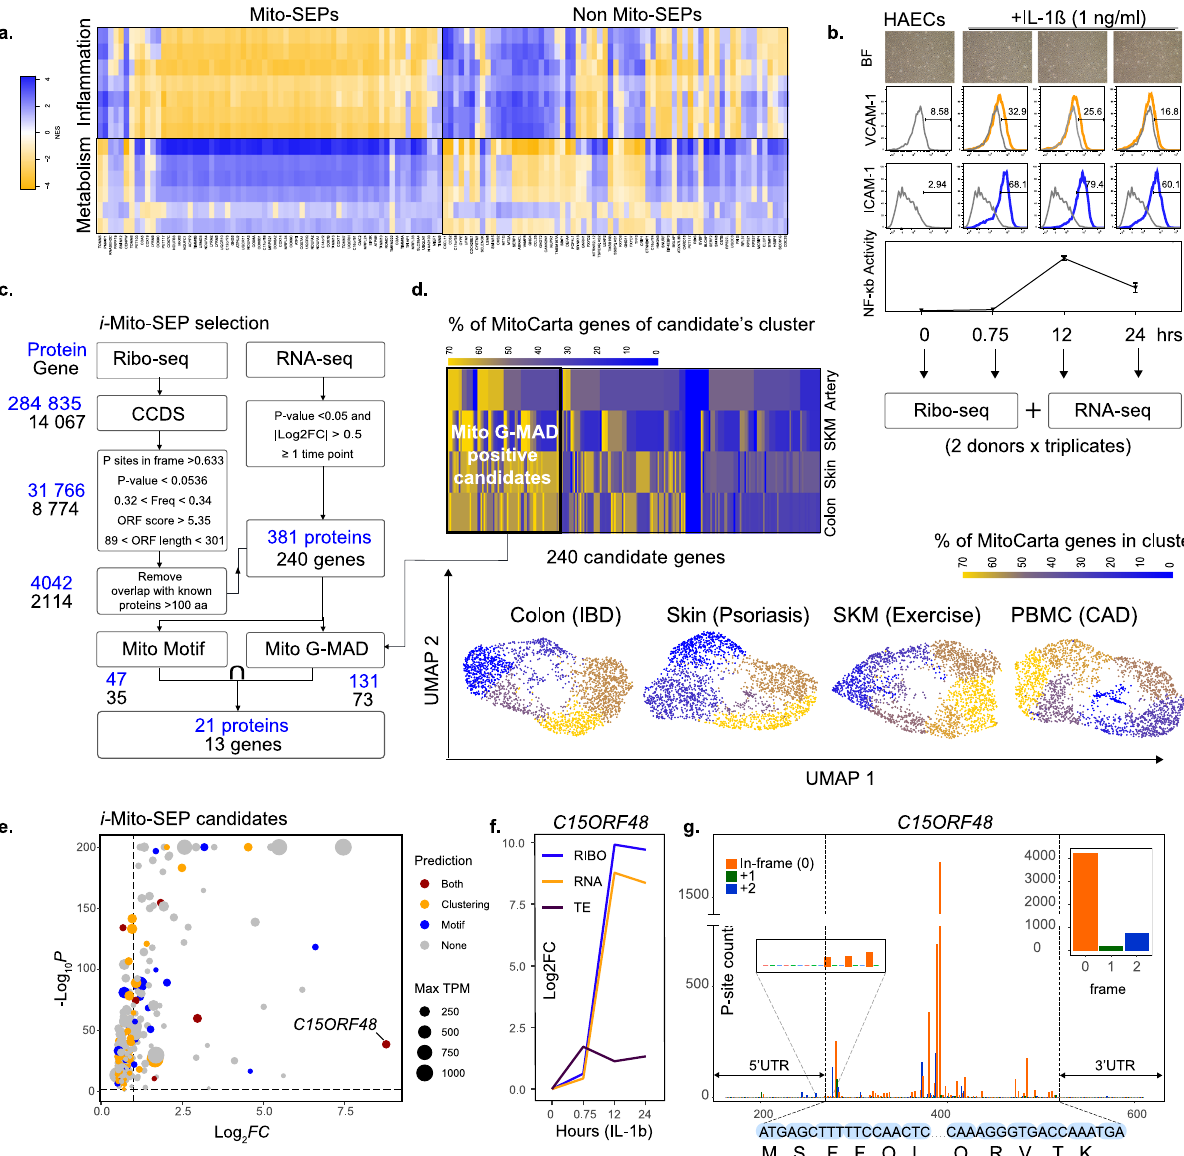
Fig. 1 Proteogenomic screen in human endothelial cells (HAECs) identi fi es MOCCI as an in fl ammatory Mito-SEP (i-Mito-SEP). a WGCNA-GSEA analysis of mito versus non-mito-SEPs in human failing heart reveals strong anti-correlation of mito-SEPs with in fl ammation. Each row represents one pathway and the pathways are separated into those that are involved in metabolism and those that are involved in in fl ammation. Color scale = NES score. Dataset used: European Genome-Phenome Archive EGAS00001002454 12 . b HAECs from two healthy male donors were treated with 1 ng/mL IL-1 β for 45 min, 12 and 24 h. All timepoints including untreated controls were analyzed by RNA-seq and Ribo-seq in triplicate. NF-kb reporter activity, ICAM-1, and VCAM-1 expression illustrate the dynamics of the HAEC response: an increase in in fl ammation up to 12 h followed by resolution thereafter. Data for NF-kb reporter activity are presented as mean ± SEM. n = 4 biological replicates for NF-kb reporter activity. c Work fl ow to identify i- Mito-SEPs. Blue numbers indicate the number of SEPs called by RiboTaper and black numbers indicate the number of genes encoding those SEPs (see methods). d Summary of the mitochondrial gene signature work fl ow. (Bottom) UMAP of gene module association determination (G-MAD) scores of MitoCarta and random genes in human colon, skin, skeletal muscle (SKM), and PBMCs undergoing in fl ammation. Color scale indicates the percentage of mitochondrial genes in each cluster. Based on their G-MAD, the 240 candidate genes from c were assigned to a cluster in each dataset. (Top) Heatmap depicting the percentage of mitochondrial genes in a candidate ’ s cluster in each of the four datasets. Each column represents one candidate. Top scoring candidates were returned to the pipeline in c for further consideration. Datasets used were: GSE11223 84 , GSE14905 83 , GSE120862 82 , and GSE9820 81 . e Volcano plot of the maximal fold change of the 240 candidate genes during the IL-1 β treatment compared to untreated cells. The size of each dot represent the highest TPM reached at any timepoint, while its color indicates if candidate SEP was predicted to localize to the mitochondria by motif, G-MAD or both. The p adjusted values were attained by applying the Wald chi-squared test, followed by correction for multiple testing using the Benjamini and Hochberg method through the DESeq2 pipeline. f MOCCI transcript and translation levels increase by 1000-fold after IL-1 β treatment. TE translational ef fi ciency. g Ribo-seq derived p-site read coverage across the MOCCI locus. In-frame (0) and out-of-frame ( + 1, + 2) colored in orange, green, and blue respectively. Inset on the left shows that p- site reads are detected only at the start codon. Inset on the right summarizes the total number of in-frame (0) and out-of frame ( + 1, + 2) reads in dataset.